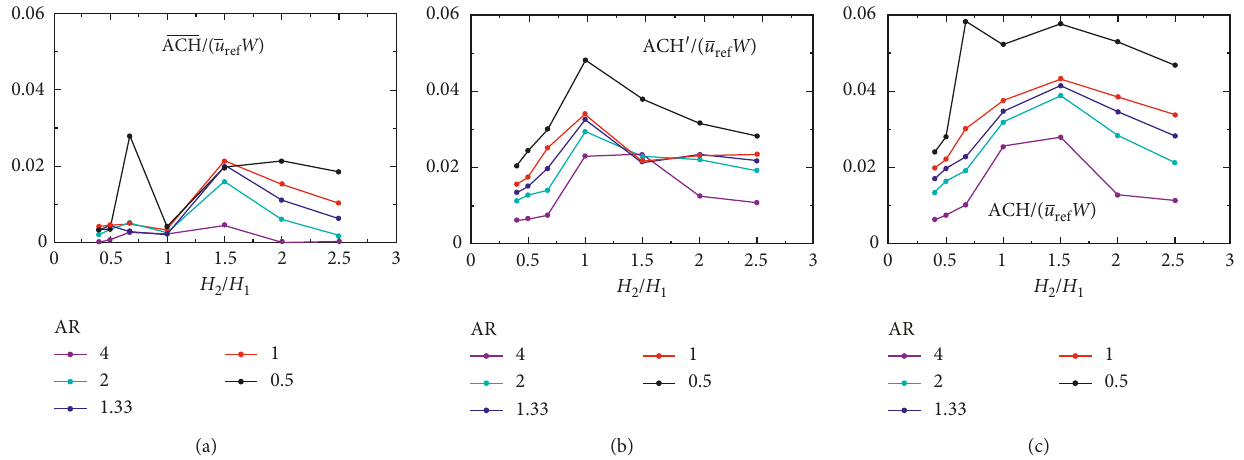
Figure 13: Nondimensional ACH components as a function of the relative building heights for five aspect ratios: (a) mean component, (b) turbulent component, and (c) total